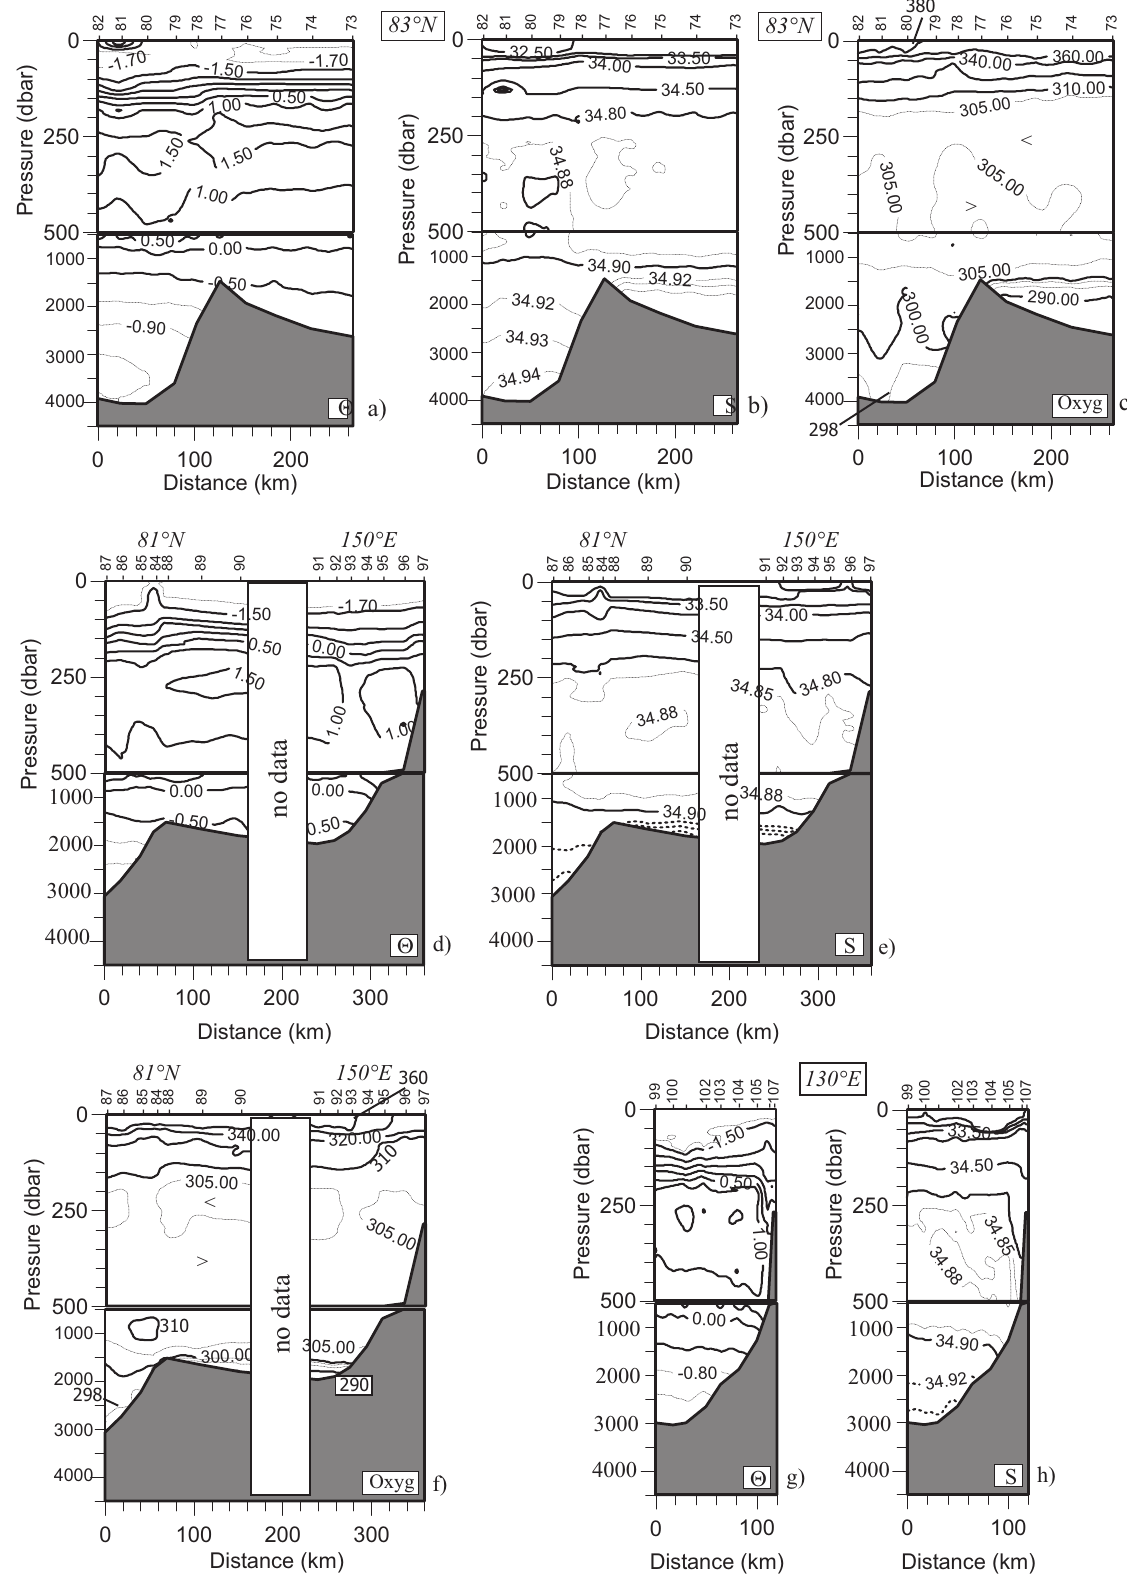
Fig. 10. Vertical distribution of potential temperature (a, d, g) , salinity (b, e, h) , and oxygen content (c, f) across the Lomonosov Ridge at 81 ◦ N and 83 ◦ N, across the continental slope in the Makarov Basin at 150 ◦ E, and across the Amundsen Basin at 130 ◦